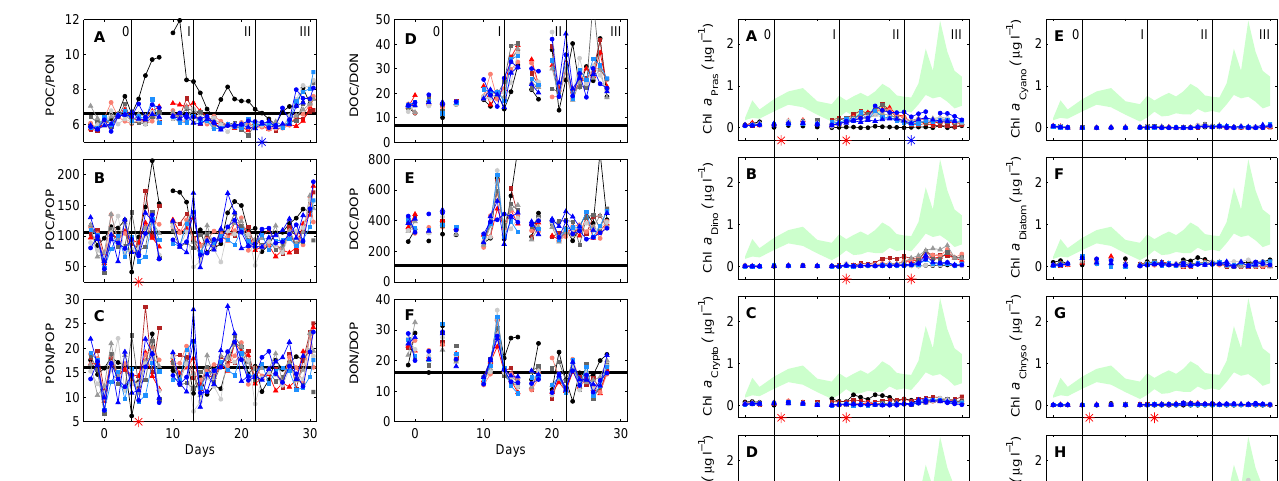
Fig. 9. Temporal development of depth-averaged (0.3–12m) ratios of particulate organic carbon to nitrogen (A) , particulate organic carbon to phosphorus (B) , particulate organic nitrogen to phospho- rus (C) , dissolved organic carbon to nitrogen (D) , dissolved organic carbon to phosphorus (E) , and dissolved organic nitrogen to phos- phorus (F) . Horizontal black lines denote elemental ratios accord- ing to Redfield et al. (1963). Style and colour code follow those of Fig. 6, and statistical results are summarized in Table 2.